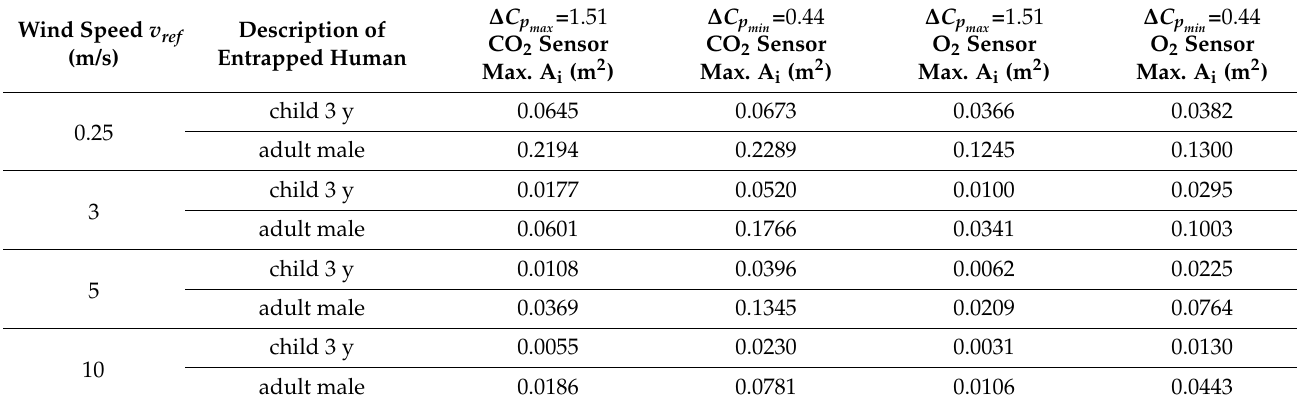
Table 8. Estimation of maximum total possible area of openings in voids (Wind and Stack effect, z = 2 m, T f − T C = 5 ◦ C. Wind Speed v ref